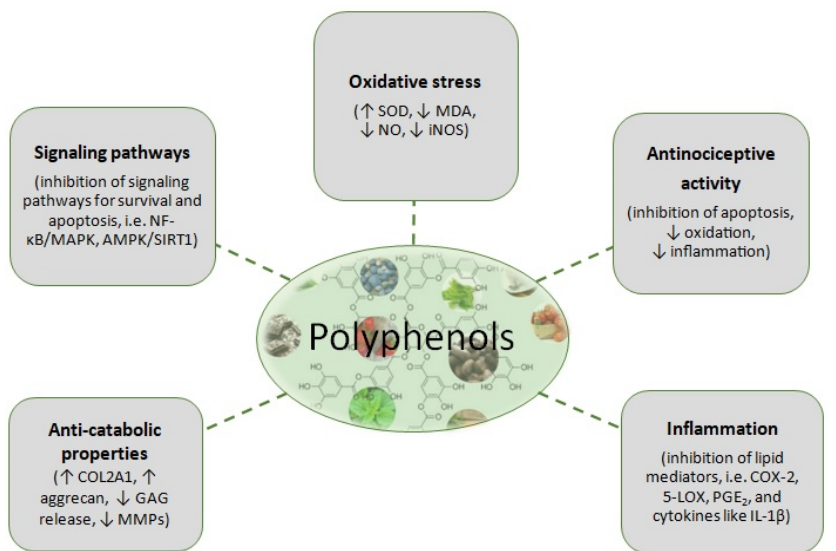
Figure 2. Putative mechanisms of action of polyphenols against OA. SOD: Superoxide dismutase, MDA: Malondialdehyde, NO: Nitric oxide, iNOS: Inducible nitric oxide synthase, COL2A1: Colla-